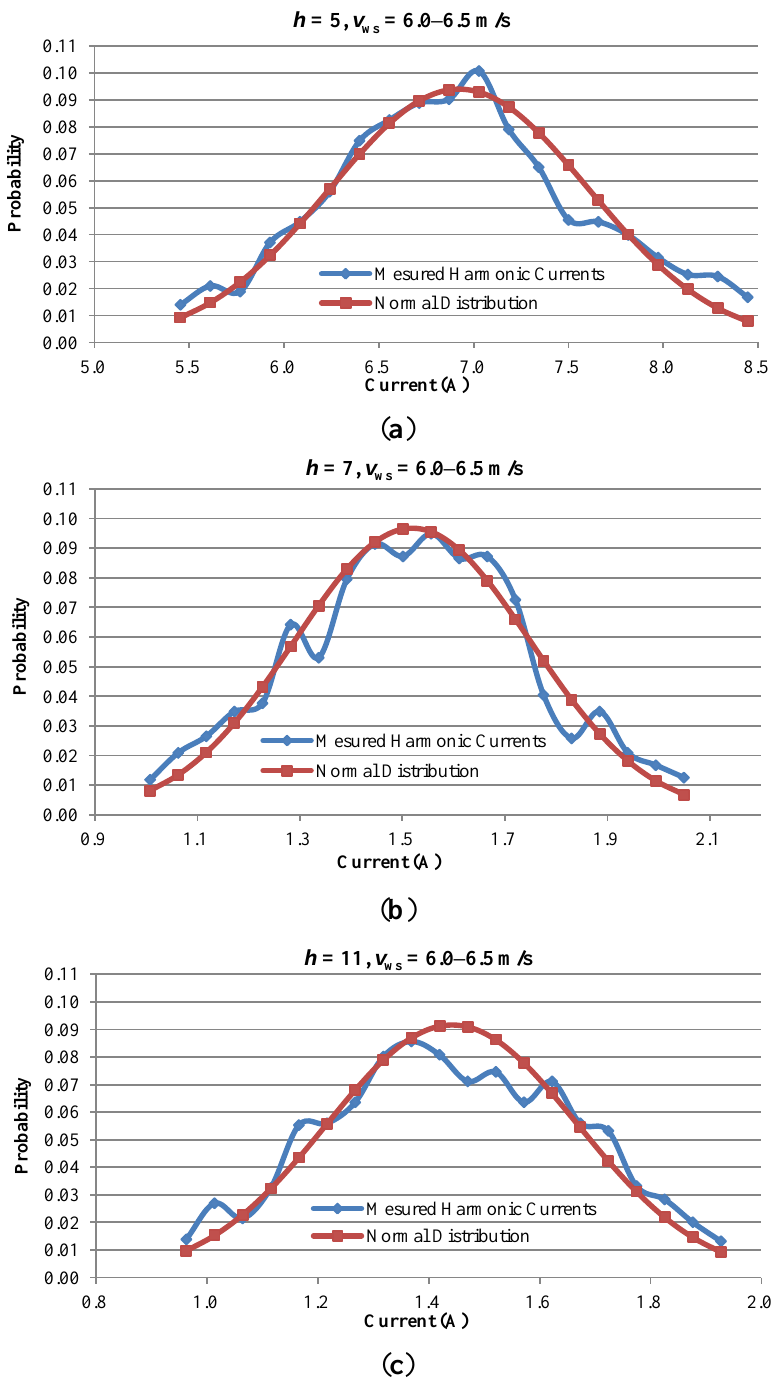
Figure 6. Probability density distributions of the 5/7/11th order harmonic currents. ( a ) 5th order harmonic current; ( b ) 7th order harmonic current; ( c ) 11th order harmonic